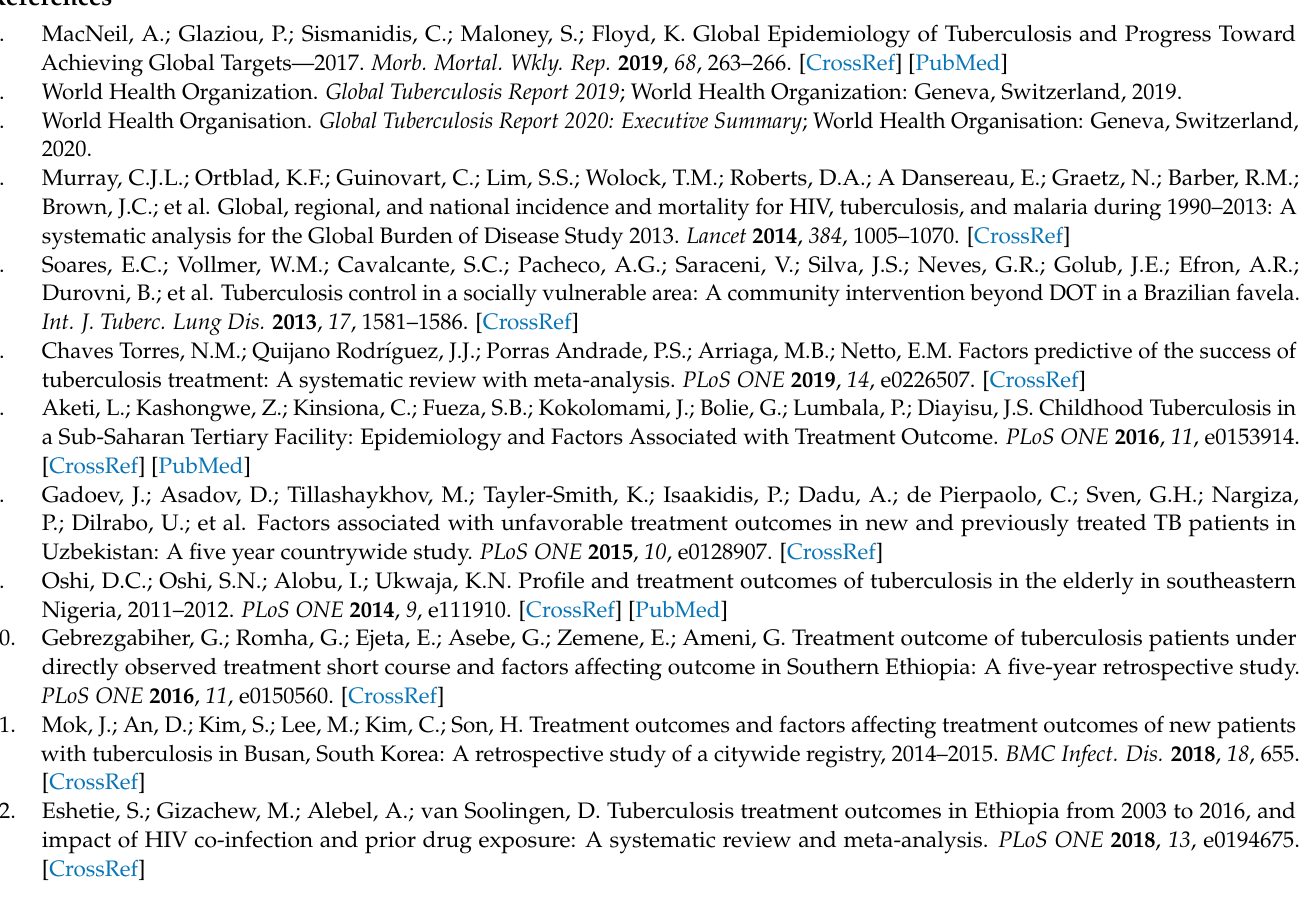
Study level risk of bias measurement, Table S2: Characteristics of included studies and TB treatment outcome status, Figure S1: Pooled and study-specific rate of unsuccessful treatment outcome related to death, Figure S2: Pooled and study-specific rate of unsuccessful treatment outcome related to the defaulter, Figure S3: Pooled and study-specific rate of unsuccessful treatment outcome related to the failure, Figure S4: Funnel plots of standard error with RR and pseudo 95% confidence limits that used to evaluate publication